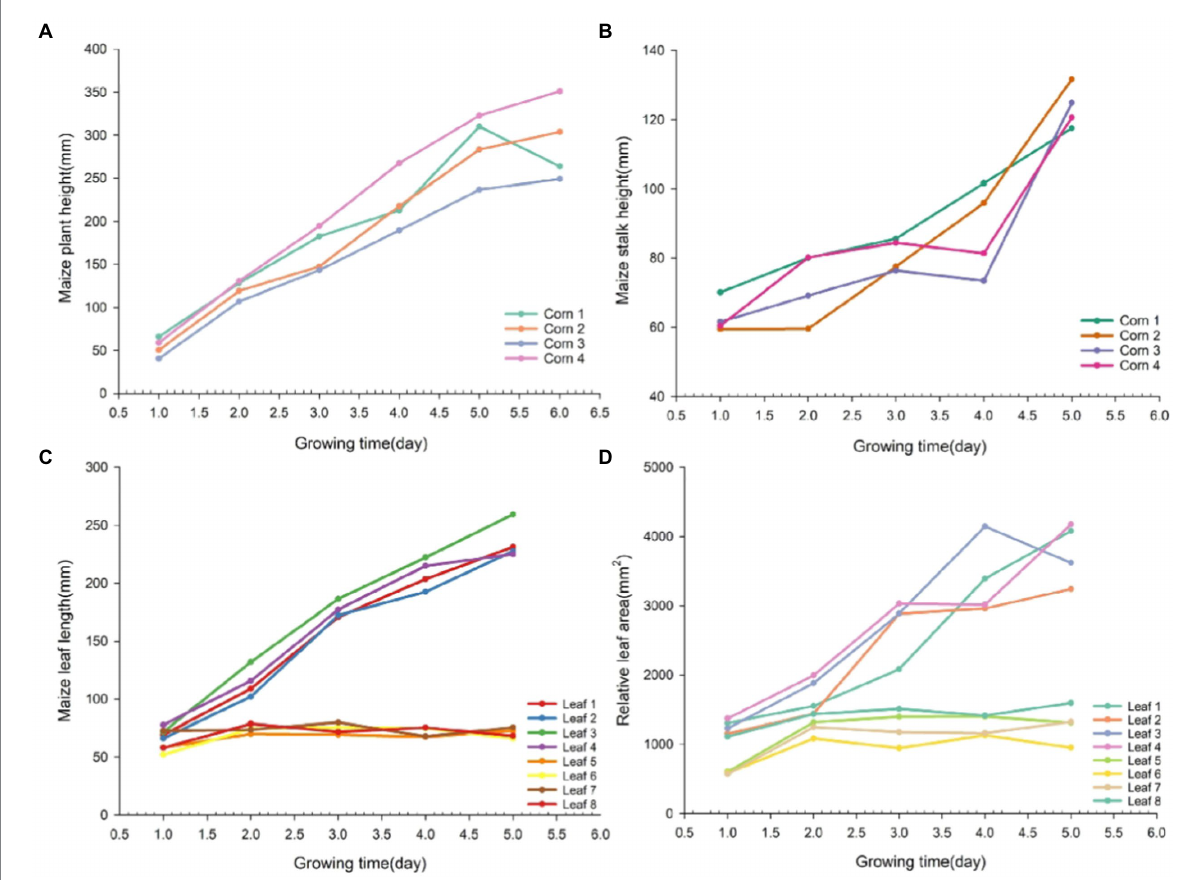
FIGURE 9 Line graph of growth dynamics of different phenotypic traits in maize. Maize phenotypic traits were plant height (A) , stem height (B) , leaf length (C) , and relative leaf area (D) in that